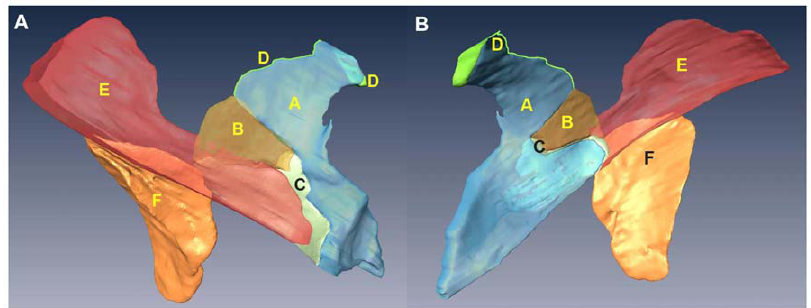
Figure 6. Visualizing the spatial relationship of the LES to the left retroperitoneal space on CVH2. (A, B) Posterointernal and anteroexternal view of the spatial relationship between LES and left retroperitoneal space in 3D. The upper pole of the left retroperitoneal space overlaps with the lower portion of the LSFS, but the left retroperitoneal space is separated from the GBA by the lower segment of left layer of the gastrophrenic ligament.Theleft retroperitoneal space communicates withthe LESacrossthe LSFS. A:GBA; B: LSFS; C:the lower segmentofleftlayerofthe gastrophrenic ligament; D: the upper segment of left layer of the gastrophrenic ligament; E: upper portion of the left retroperitoneal space; F: left adrenal gland.